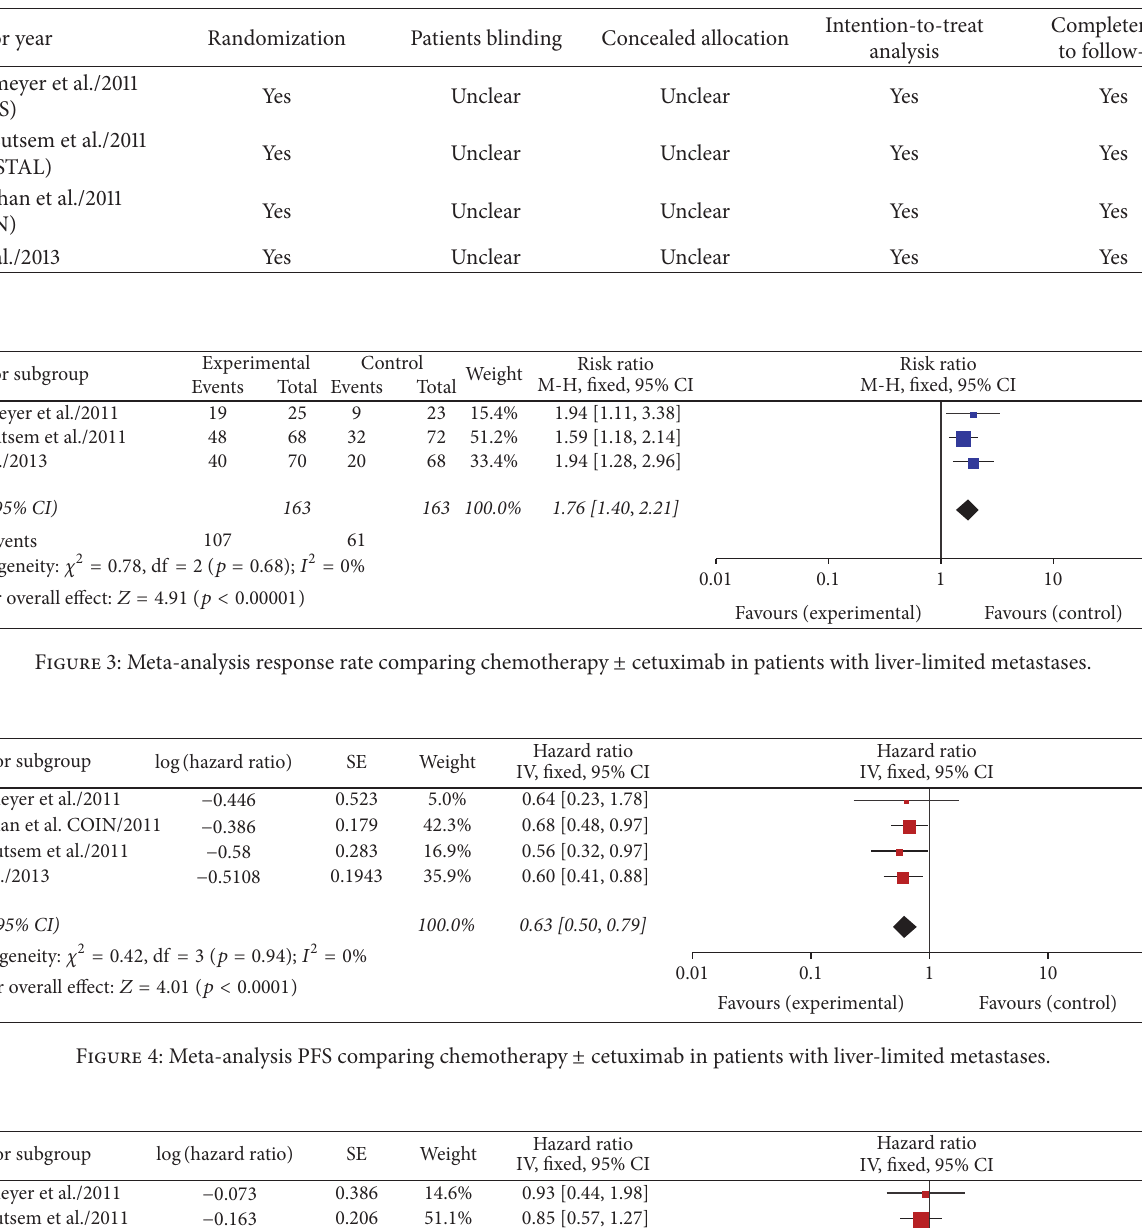
Hazard ratio IV, fixed, 95% CI